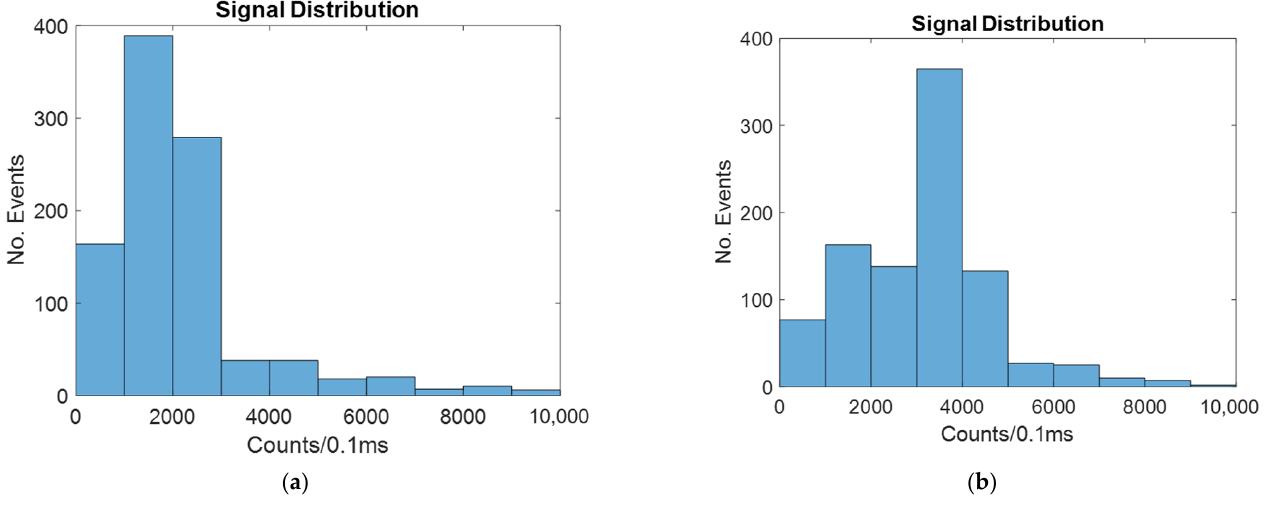
Figure 10. Histograms showing the number of counts at di ff erent intensities for a biosensor illumi- nated by a twenty-micron spot laser with: ( a ) no hydrodynamic focusing; ( b ) 2D hydrodynamic focusing.